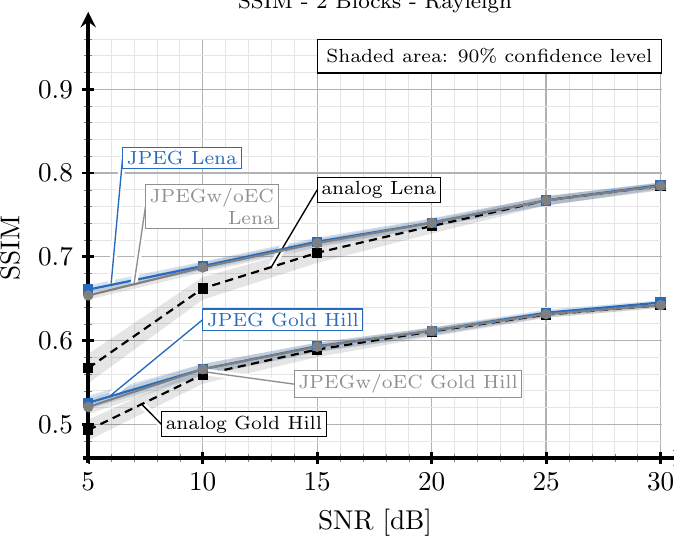
Figure 17. SSIM vs. SNR for two blocks and Rayleigh channel.